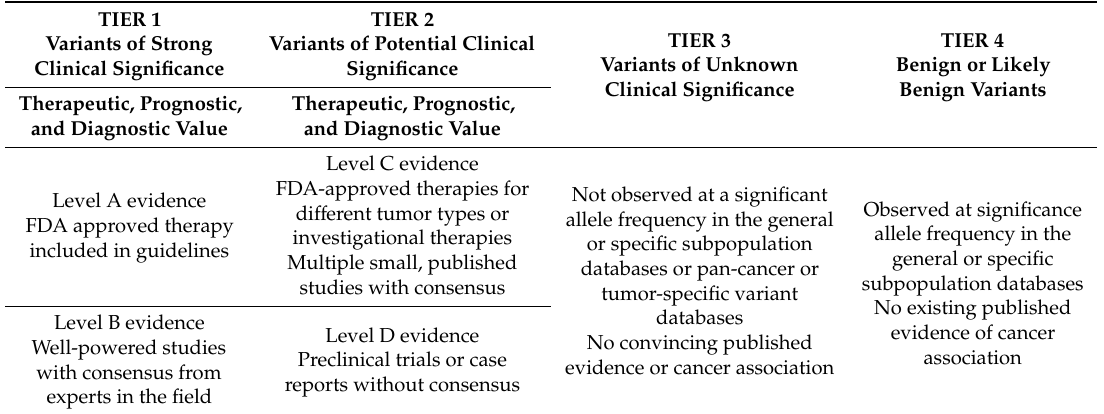
Table 1. Level of actionability of the molecular